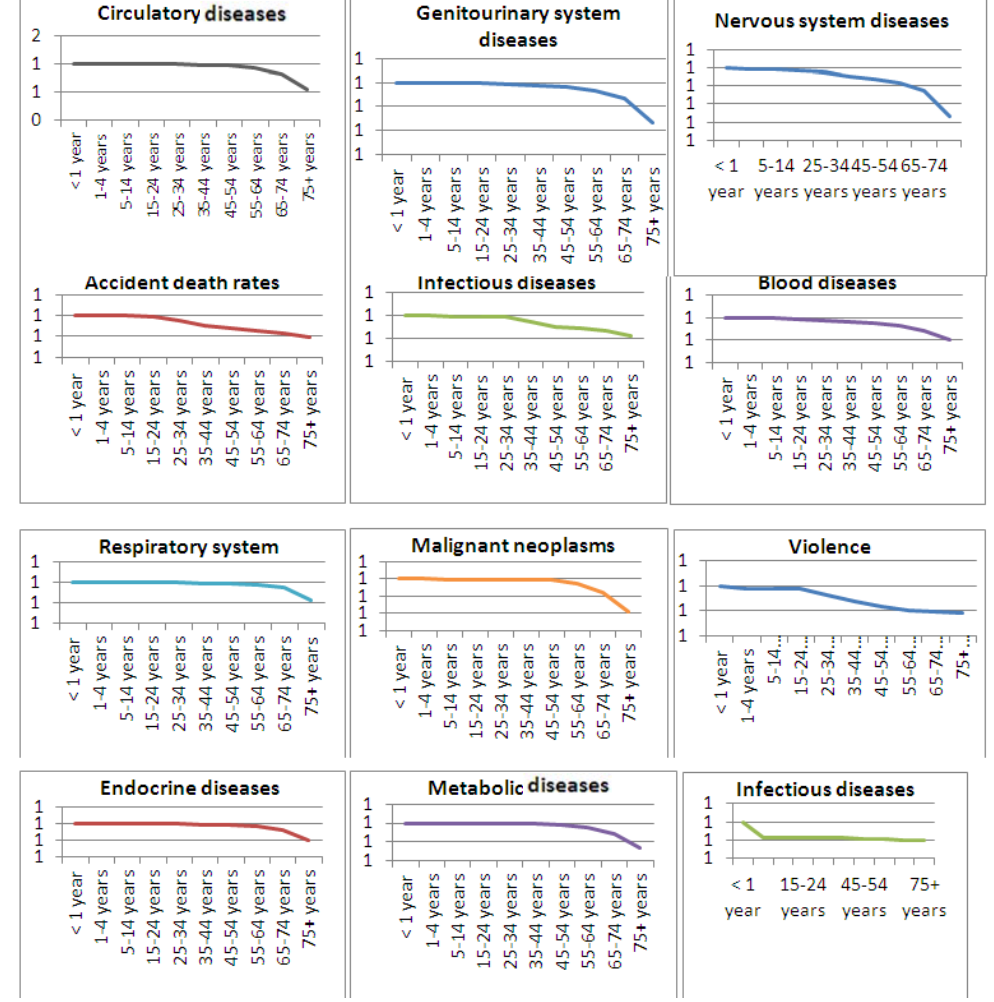
Fig. 4. Forecasted central death rates – decomposition by causes of death, Italian total population